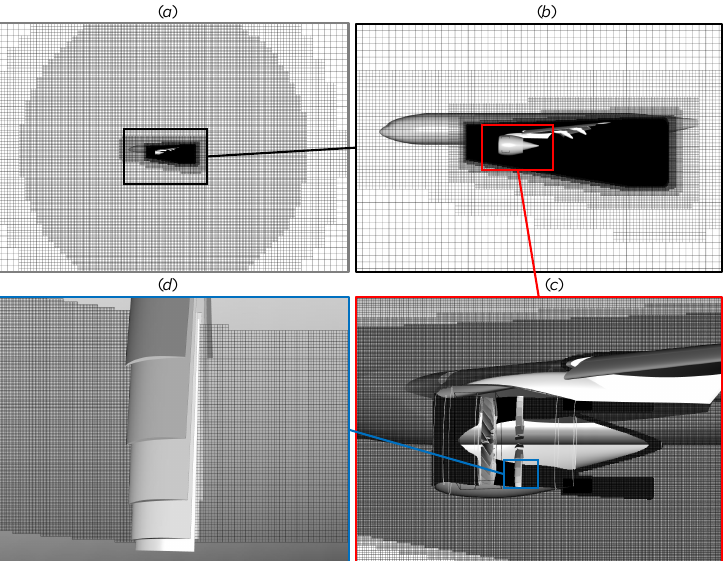
Figure 4. The voxel distribution in the simulation domain: ( a ) near the borders of the acoustic sponge boundary; ( b ) surrounding the airframe; ( c ) surrounding the SDT fan stage; ( d ) near the